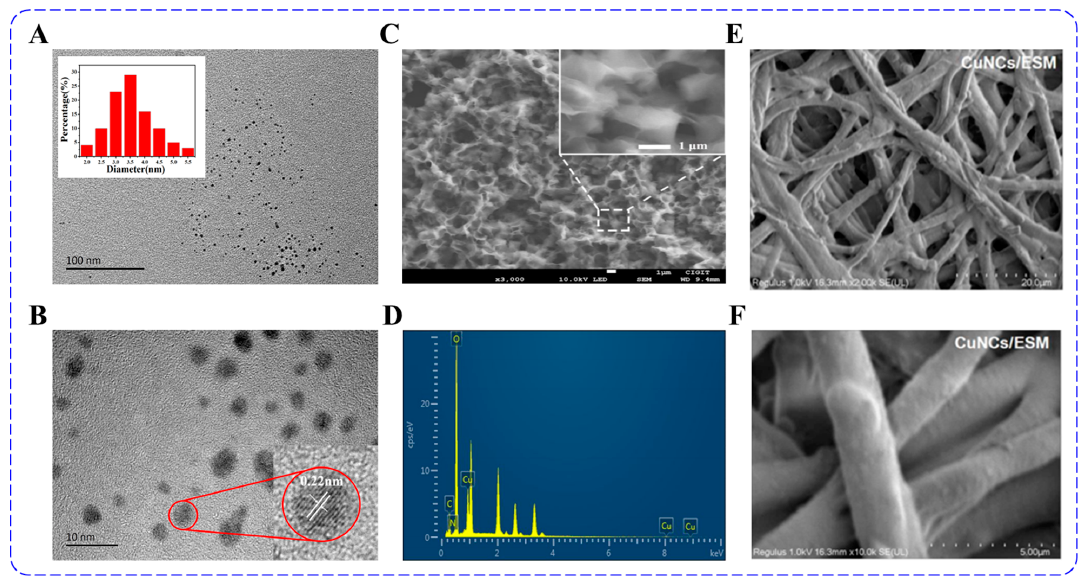
Figure 4. TEM ( A ) and HR-TEM ( B ) images of MMI-CuNCs [53], Copyrights from American Chem- istry Society, 2022. SEM image ( C ) and EDX spectrum ( D ) of CuNCs synthesized in poly-L-Cys film [58], Copyrights from American Chemistry Society, 2020. FE-SEM images of CuNCs/ESM at a mag- nification of 2000 ( E ) and 10000 ( F ) respectively [56], Copyrights from Springer,